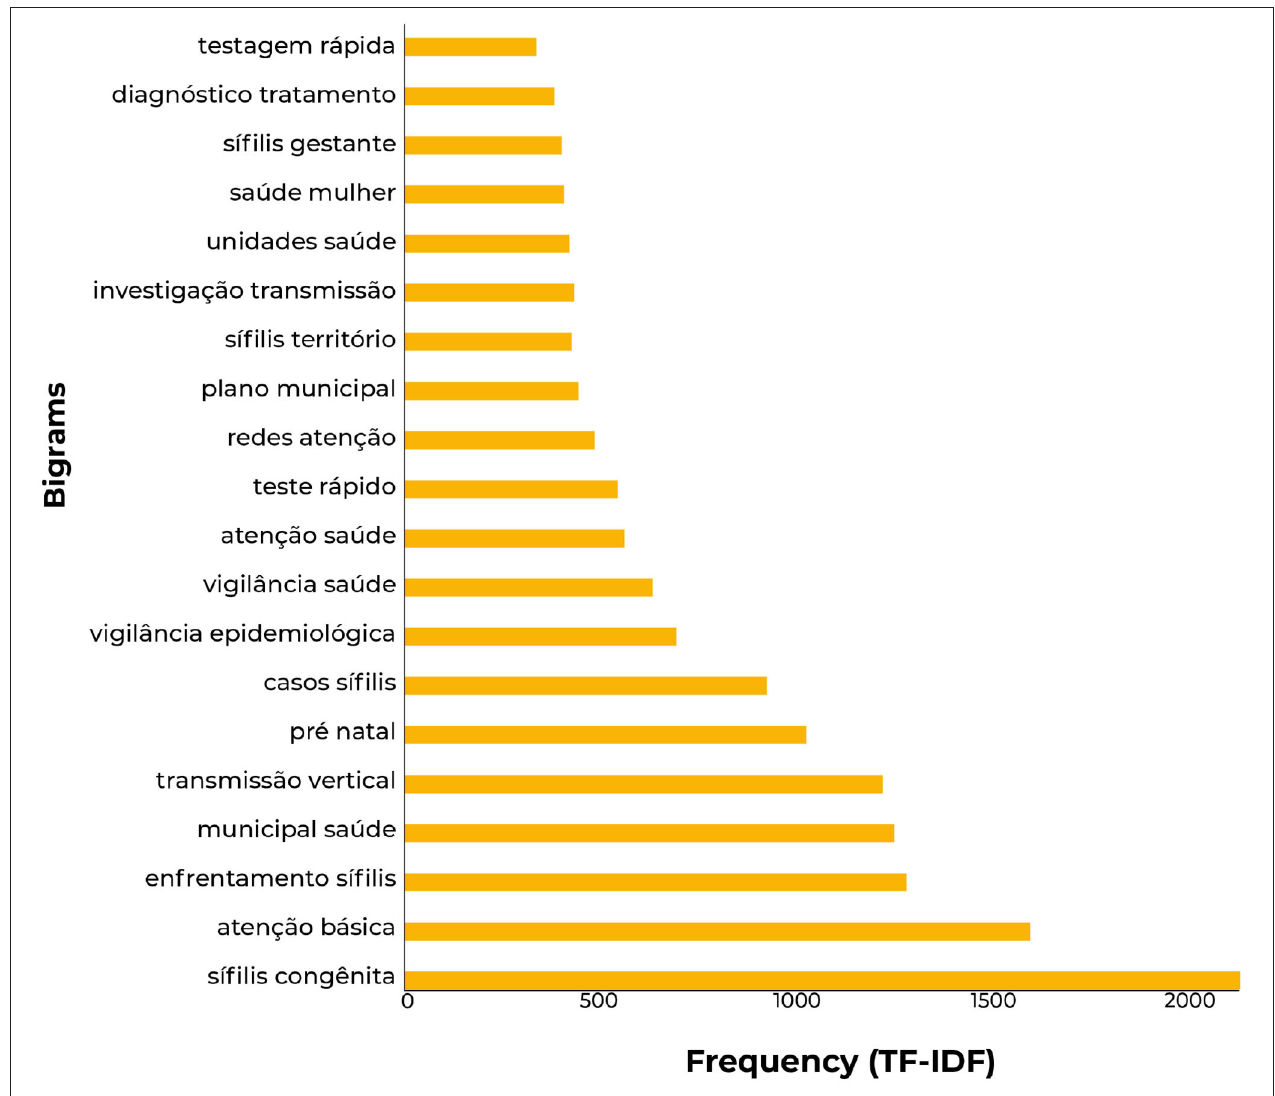
FIGURE 5 | The 20 most common bigrams in reports.